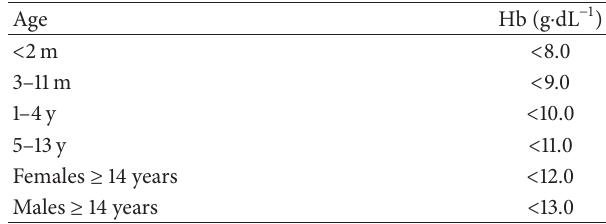
Table 1: Anemia as defined by hemoglobin (Hb) levels based on